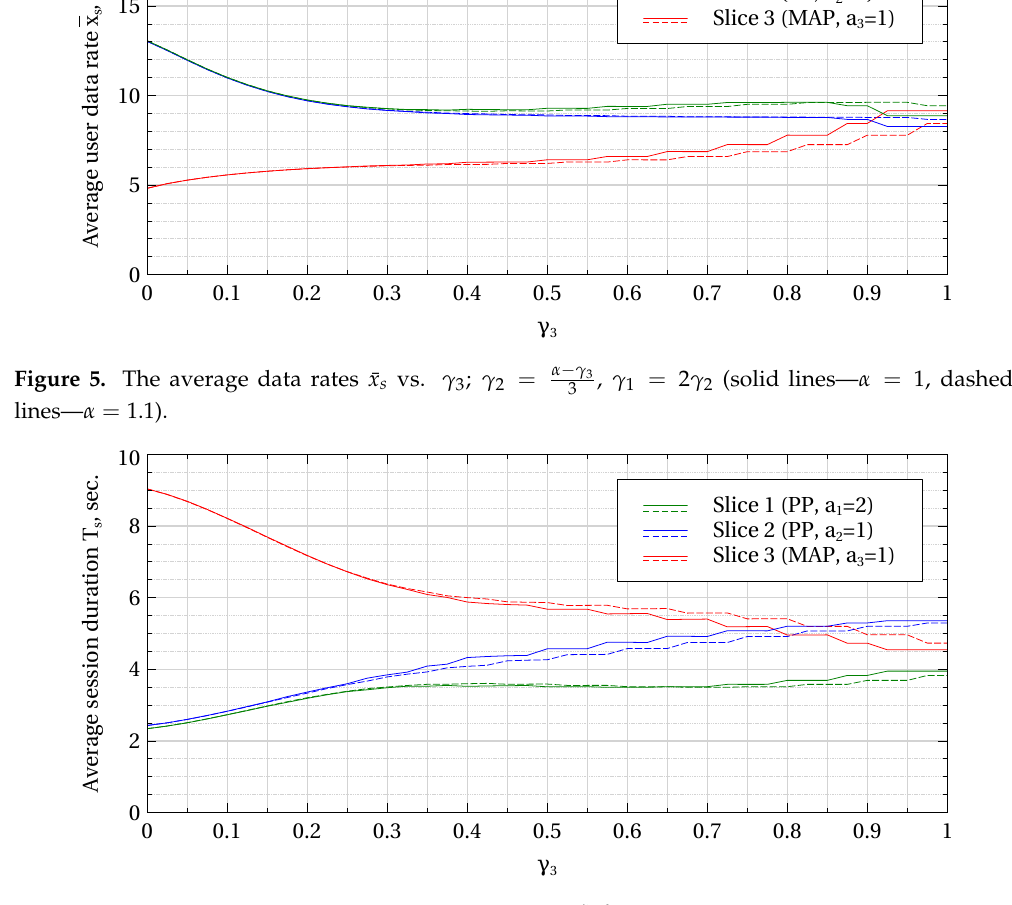
, γ 1 = 2 γ 2 (solid lines— α = 1, dashed 3